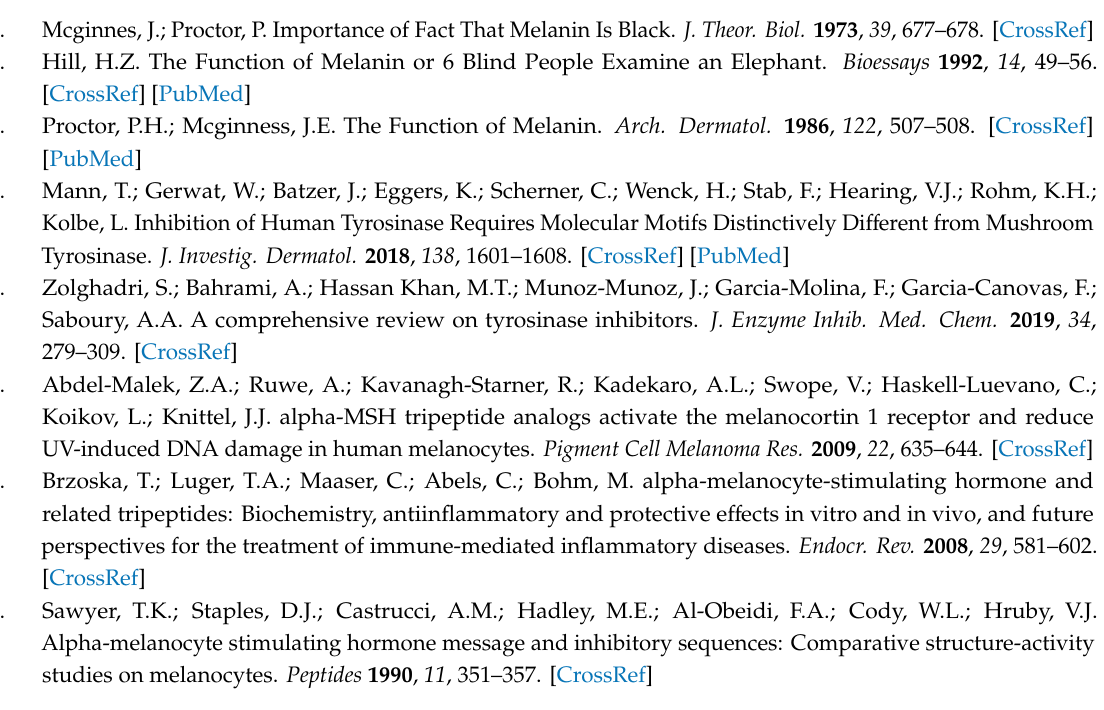
Table S1: Purity of peptides, Figure S1: Determination of IC 50 values of MHIRL peptide family, Figure S2: Lipid peroxidation inhibition (%) of antioxidant peptides, Figure S3: E ff ects of the MHIR peptide on melanogenesis-related